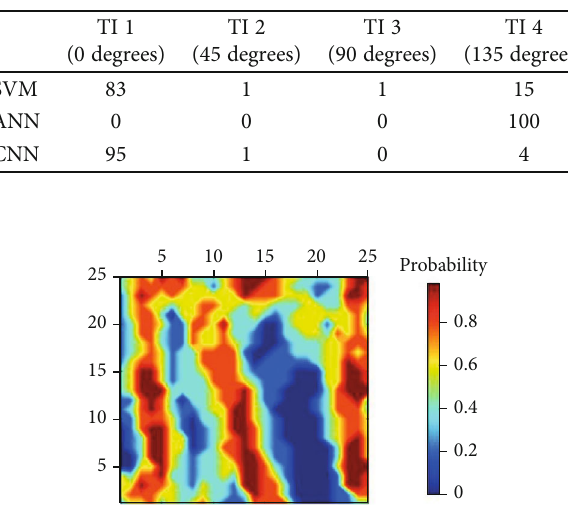
Figure 13: Pseudo facies probability map for sand